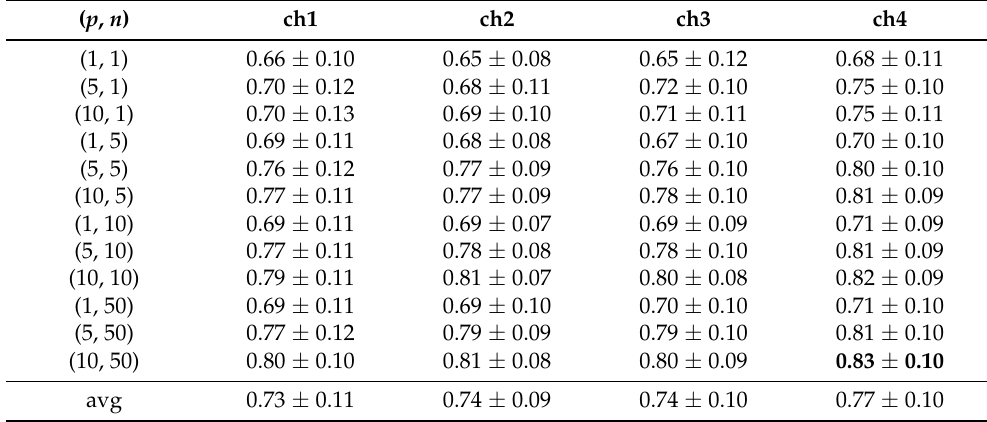
Table 7. A3S-Rec dataset: AUPRC of the 2-way 10-shot A3S-Synth prototypical model, considering internal labeling for the recordings of channels